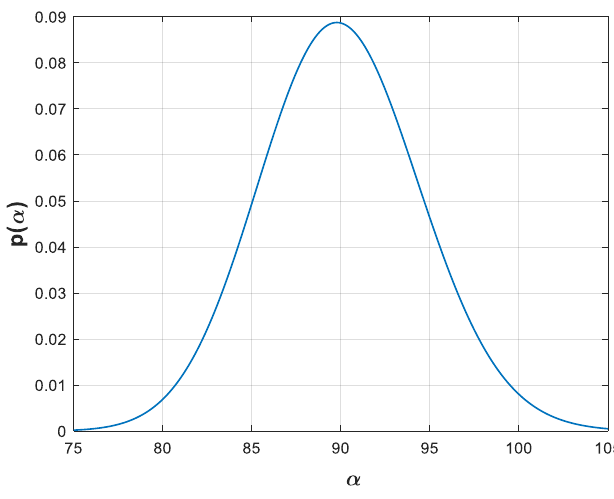
Figure 3. The prior gamma PDF of a with mean E[a] = 90 and CV: CV[a] = 0.05 for case C11.